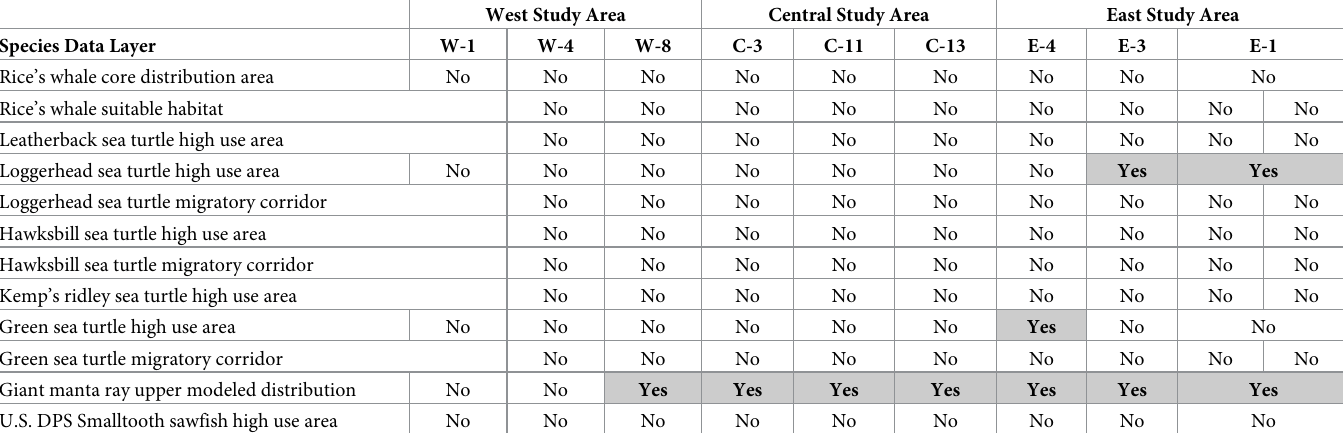
Table 3. Potential siting conflicts with protected species from final aquaculture opportunity area